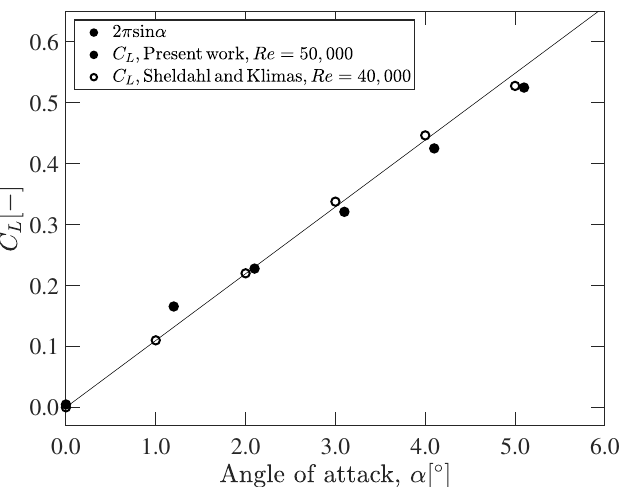
Fig. 6: Lift coefficient C L of the rigid foil measured at different values of the angle of attack in steady conditions and comparison with values measured by Sheldahl and Klimas [15] and those predicted by thin airfoil theory ( C L = 2 π sin α ).